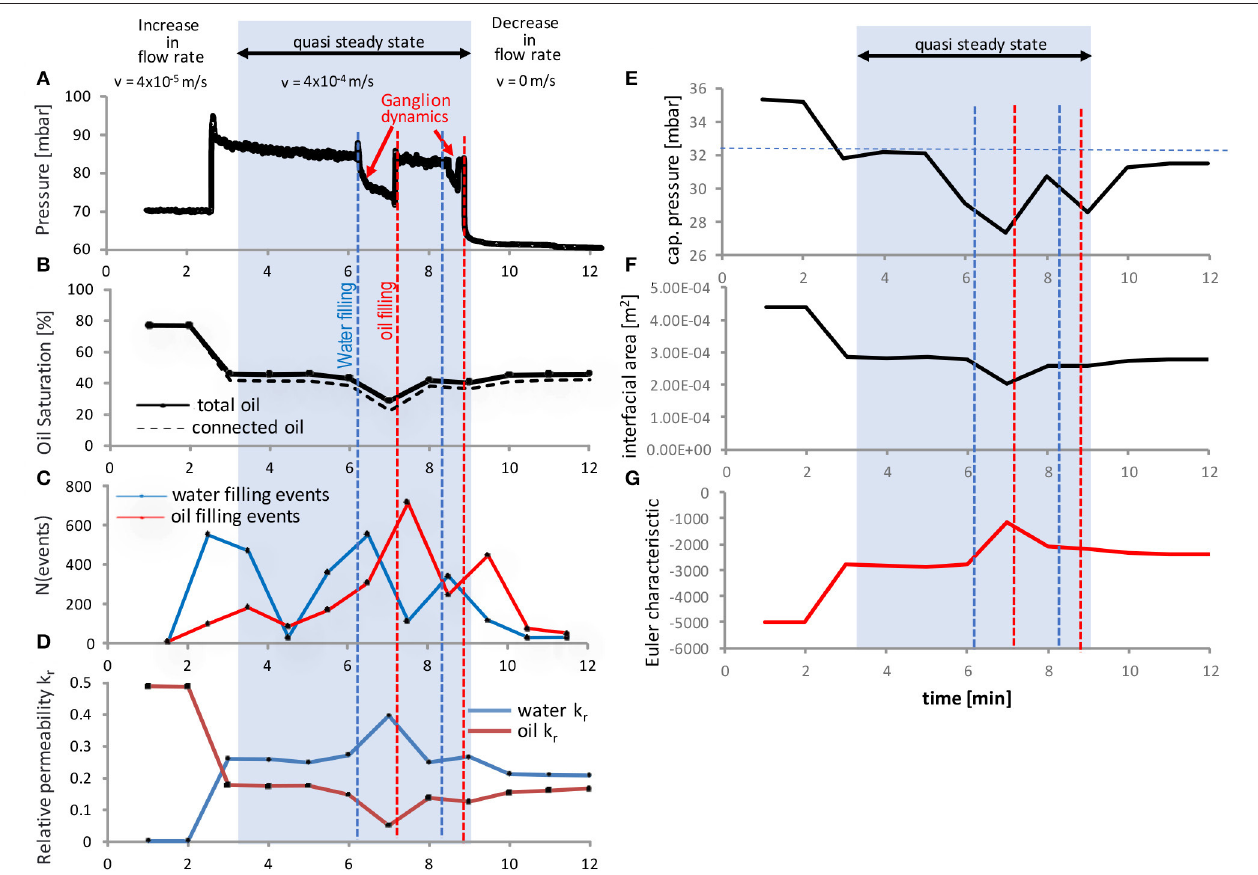
FIGURE 11 | Pressure drop (A) , water saturation (B) , event statistics (C) connected pathway relative permeability k r of connected water and oil phases (D) , capillary pressure p c obtained from the mean curvature (E) , interfacial area, (F) and the Euler characteristic for the oil phase (G) for the experiment at f w = 0.5 and v = 4 · 10 − 4 m / s . The fluctuation events with a clear pressure and saturation signature are caused by a sequence of water and oil filling events. They are causing changes in the connectivity of water and oil phases as visible in the connected pathway relative permeability, which was computed by Stokes flow simulations of the imaged water and oil phases in relation to the (analogous computed) permeability of the respective pore space. The capillary pressure largely follows the saturation and connectivity behavior, which all typically lag behind water or oil filing events, respectively. Note that capillary pressure shows a clear signature also for the 2nd filling event, which is much less visible in saturation, interfacial area ( Joekar-Niasar and Hassanizadeh, 2011) and Euler characteristic (Herring et al.,